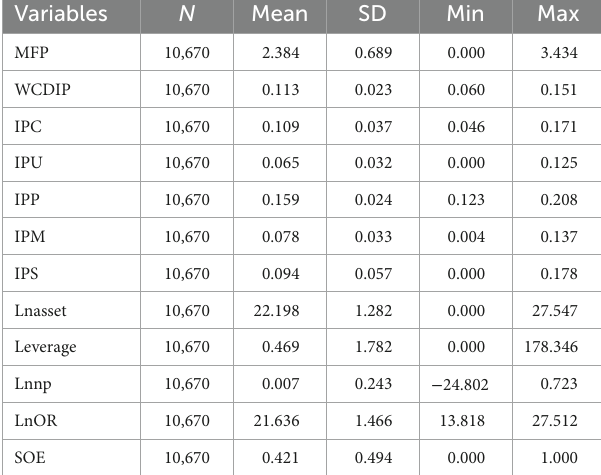
TABLE 2 Descriptive statistics of variables.